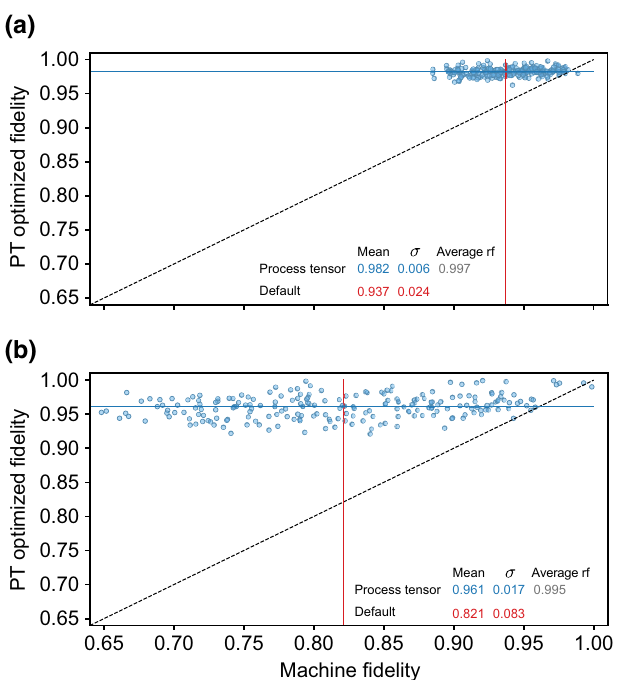
FIG. 9. The results of using the process tensor (PT) to optimize multitime circuits with different random single-qubit unitaries. The x axis indicates the fidelity compared to ideal when the sequences are run on the device. The y axis is the fidelity of the sequence when the process tensor is used to optimize to the ideal case. (a) Here, we have three sequential unitaries with a wait time interleaved similar to that of two CNOT gates (0.71 μ s) on the ibmq_manhattan (no background). (b) A similar setup is considered on ibmq_bogota but with the neighboring qubit in a |+(cid:6) state and subject to four CNOT gates per time step (2.5 μ s) ( |+(cid:6) and CNOT